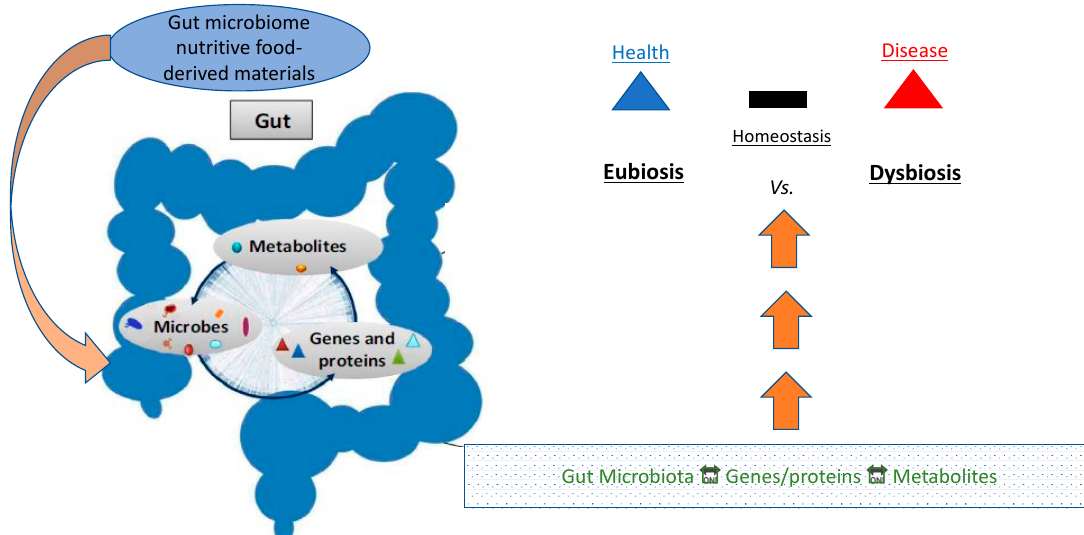
Figure 1. Conceptual schematic pictogram illustrating the relationship axis of microbes, metabolites, and gene expression vs. eubiosis/dysbiosis balance and disease risk.